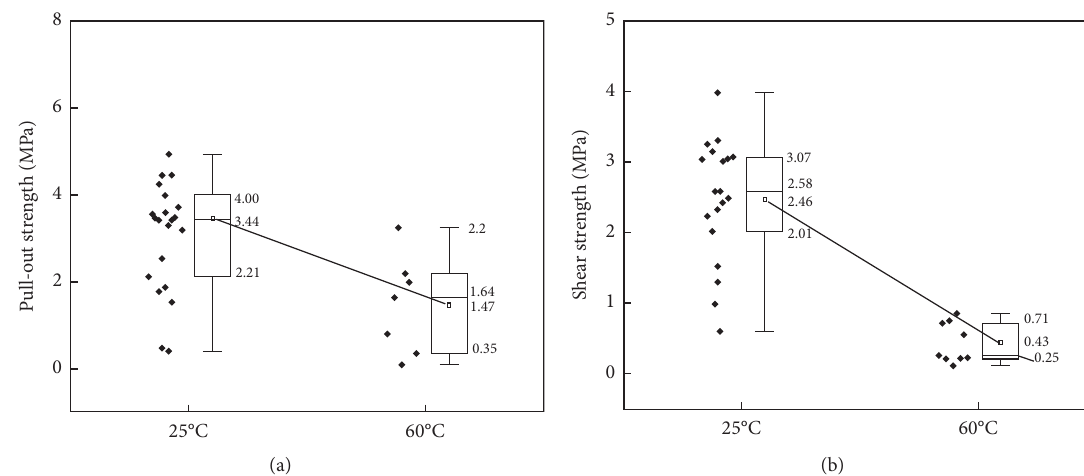
Figure 12: Bonding properties of MMA waterproof adhesive layer: (a) pull-out strength; (b) shear